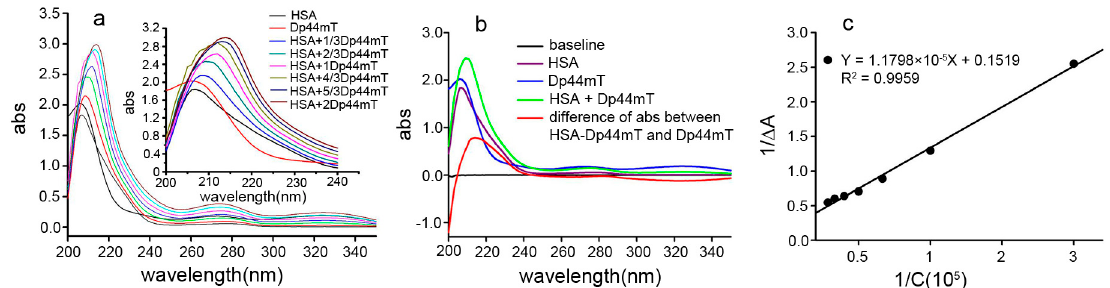
Figure 2. The interaction of Dp44mT with HSA. ( a ) Spectral changes upon addition of Dp44mT. The redshift around 214 nm is shown in the insert; ( b ) the difference spectrum between Dp44mT and HSA-Dp44mT; and ( c ) linear plots for 1/ ∆ (cid:1827) abs versus 1/[Dp44mT] at 288 K.